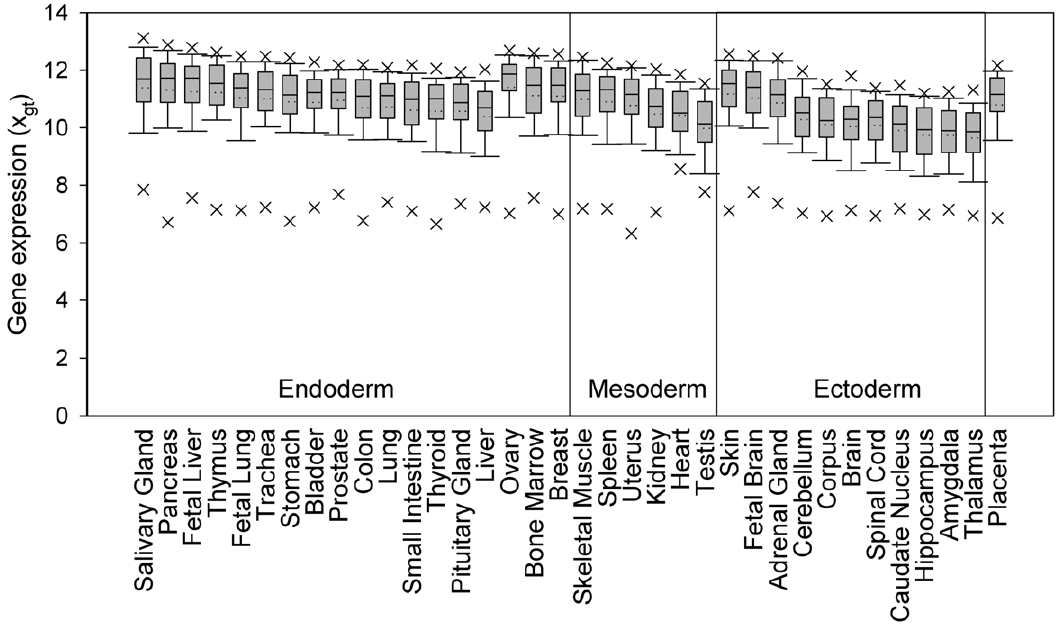
Figure 7. The ribosomal HK genes are expressed at different levels in tissues of different embryonic origins. Shown are boxplots of expression levels on a log2 scale ( x gt ) for 79 ribosomal HK genes (94.1% of the 84 ribosomal genes, Table 2) in each human tissue. Each box is bounded by the 25 th and 75 th percentile of the data, the solid line within the box marking the median. The two short horizontal bars indicate the 90 th and 10 th percentile of the data, while the crosses mark the 95 th and the 5 th percentile of the data. The tissues are grouped according to their